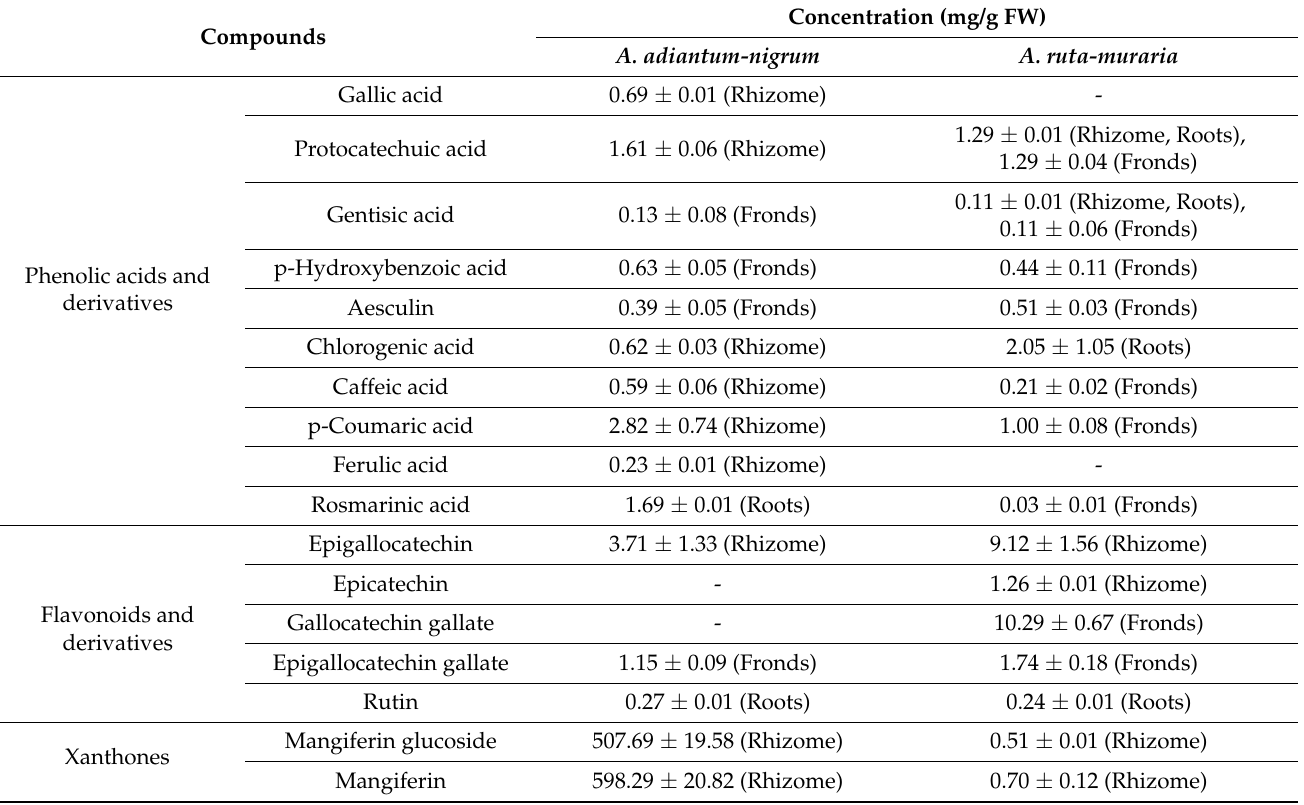
Table 1. Compounds present in the vegetative organs of A. adiantum-nigrum and A. ruta-muraria .